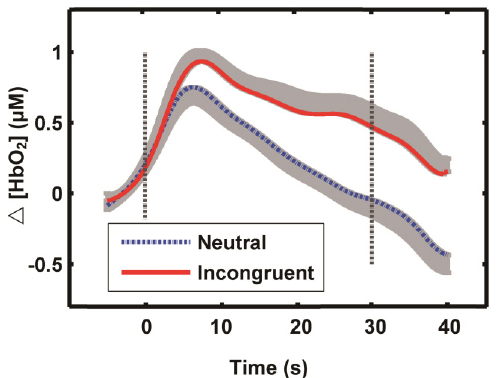
Fig. 3. Grand average time courses of HbO 2 signals to incongruent (red) and neutral (blue) tasks at typical Ch. 13. The dotted lines at 0 and 30 s indicate the start and end of task block. The shadow area indicates